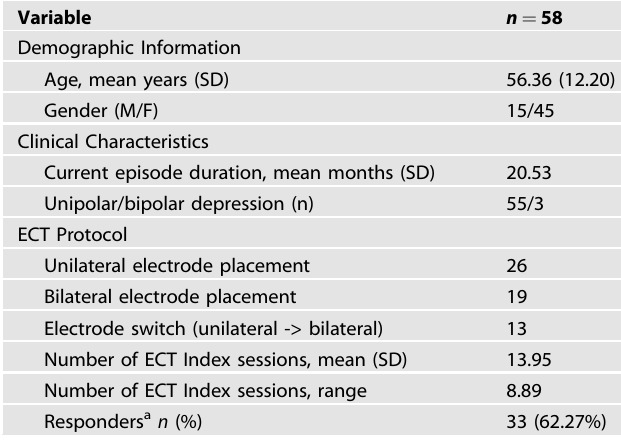
Table 1. Demographics, clinical characteristics, and ECT protocol information.